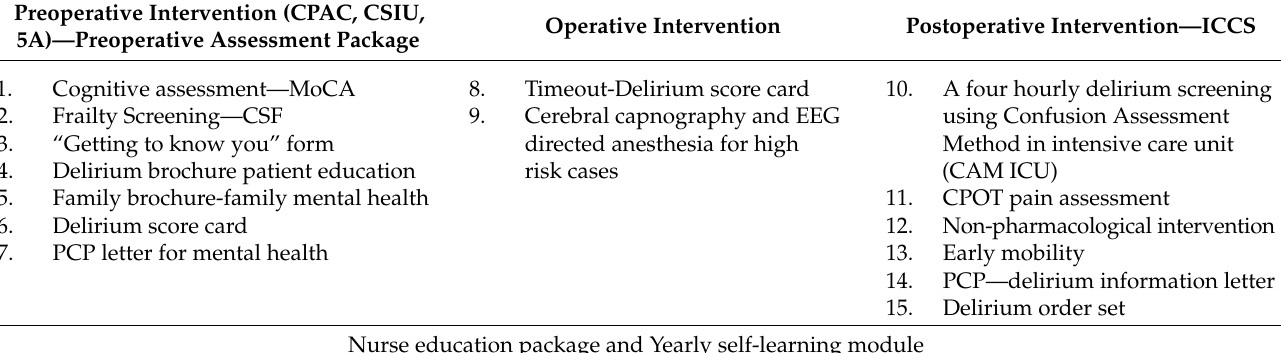
Table 2. Components of rPOD care